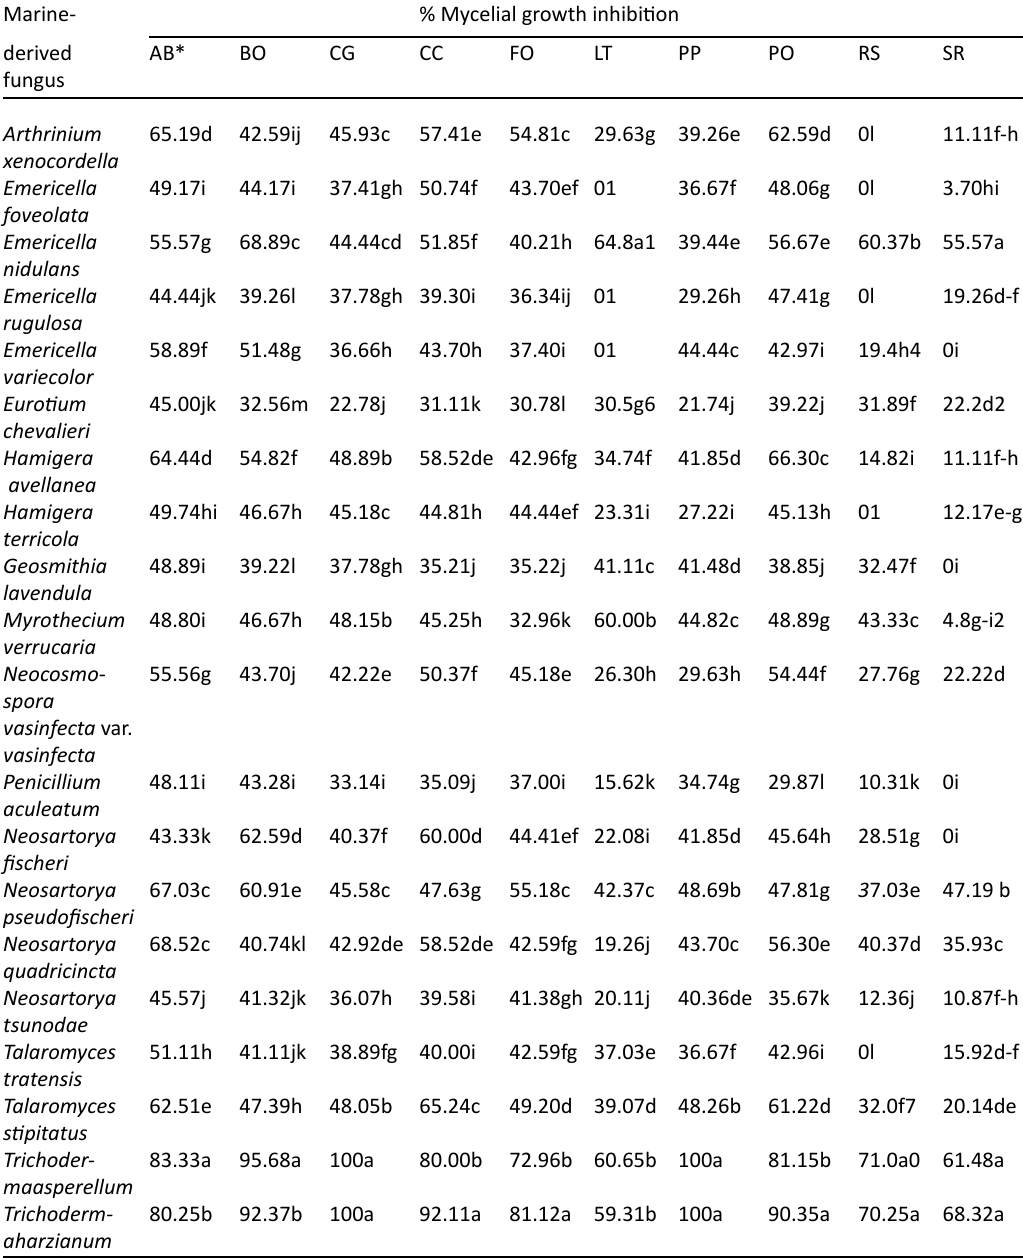
*AB = Alternaria brassicicola , BO = Bipolaris oryzae , CC = Colletotrichum capsici , CG = C . gloeosporiodes , FO= Fusarium oxysporum , LT = Lasiodiplodia theobromae , PP = Phytophthora palmivora , PO = Pyricularia oryzae , RO = Rhizoctonia oryzae , SR = Sclerotium rolfsi